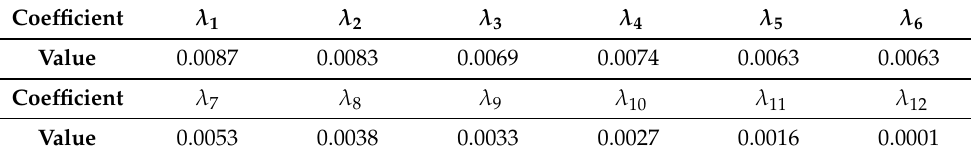
Table 2. The results of λ